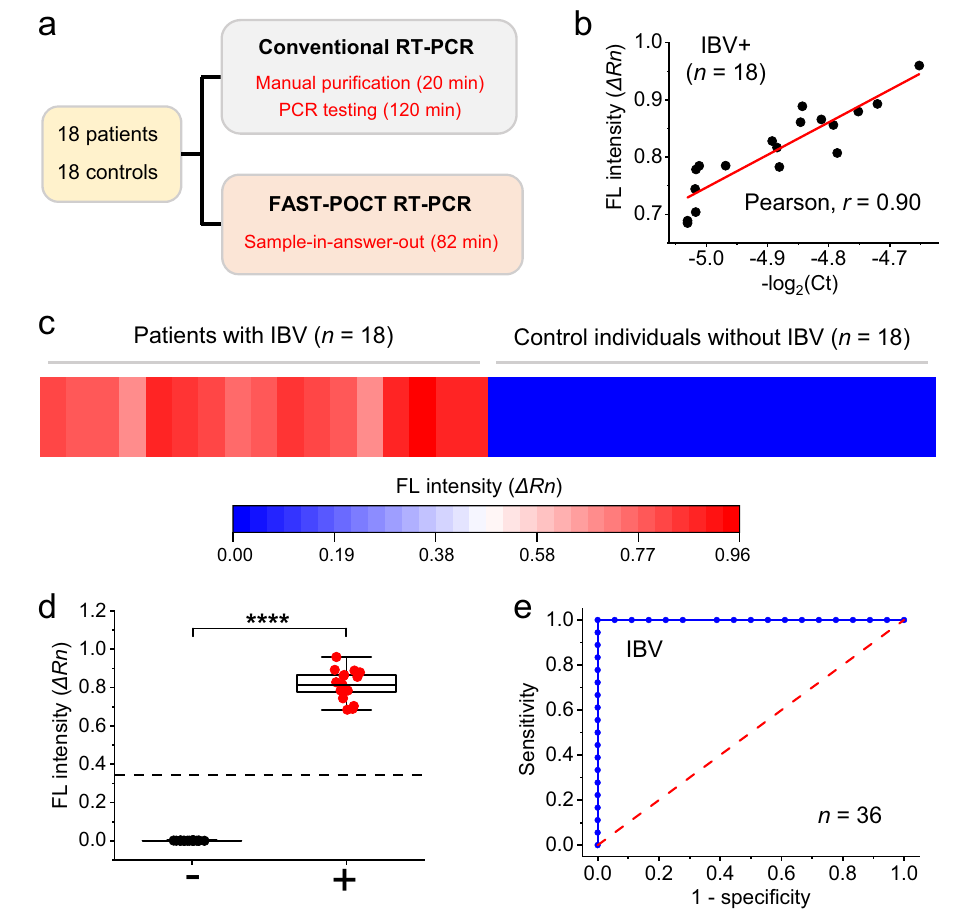
Fig. 6 | Testing of clinical samples with FAST-POCT platform for In fl uenza diagnosis. a Clinical study design. A total of 36 samples were analyzed by FAST- POCT platform and conventional RT – PCR, including 18 patients ’ samples and 18 control individuals without In fl uenza. b Evaluation of analytical concordance between FAST-POCT PCR and conventional RT-PCR. The results were positively correlated (Pearson ’ s r =0.90). c Fluorescence intensity levels for 18 patients with IBVand18controls. d FLvaluesweresigni fi cantlyhigherinthepatientswithIBV(+)